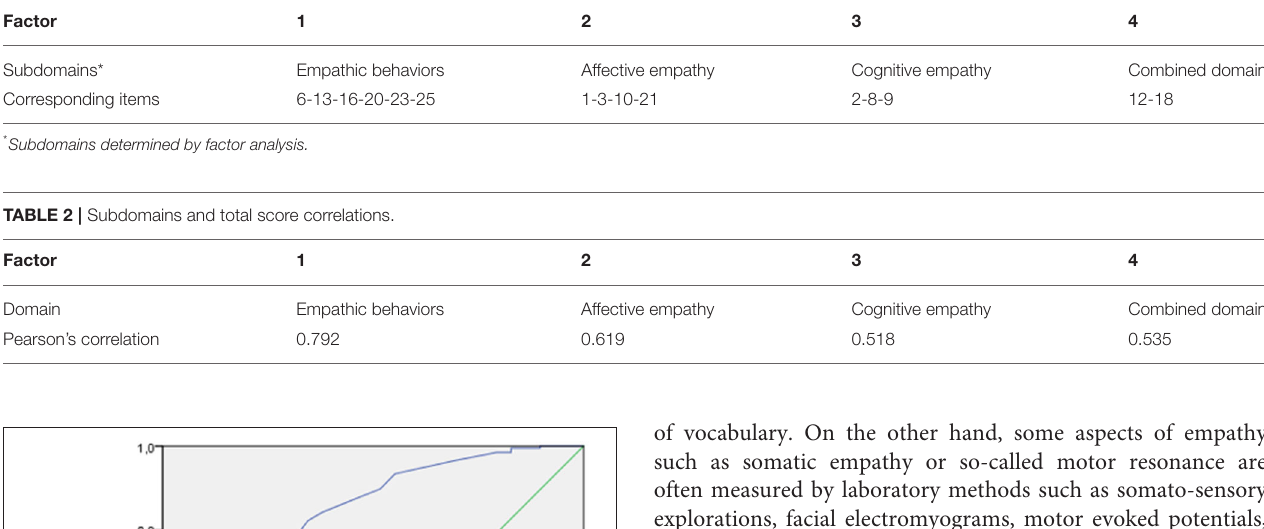
TABLE 1 | Subdomains of the TESC as determined by factor analysis.